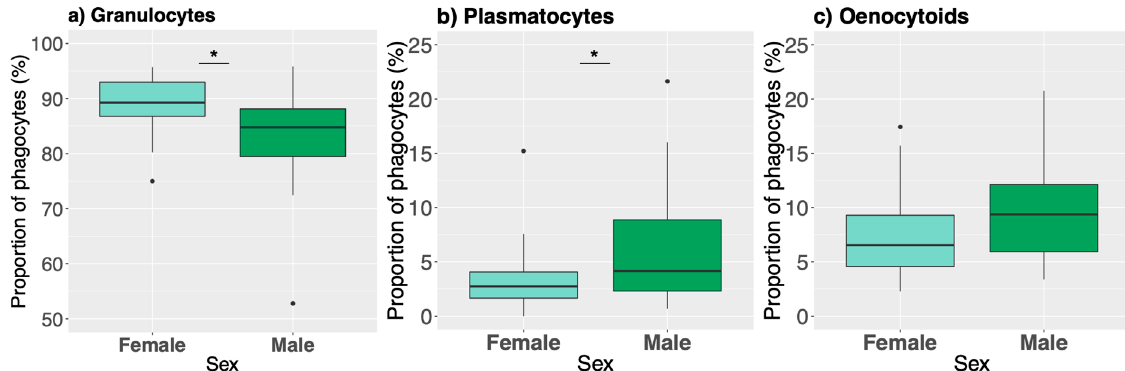
Figure 5. Differences between the sexes in cell composition of the phagocytes as measured via imaging ( N = 44). ( a ) The majority of the phagocytes were granulocytes. ( b ) Males had significantly more phagocytic plasmatocytes compared to females. ( c ) Males showed a trend towards a highe proportion of phagocytic oenocytoids. Bar plots are as described previously. Asterisks denote significance (*: P ≤ 0.05; **: P ≤ 0.01; ***: P ≤ 0.001).